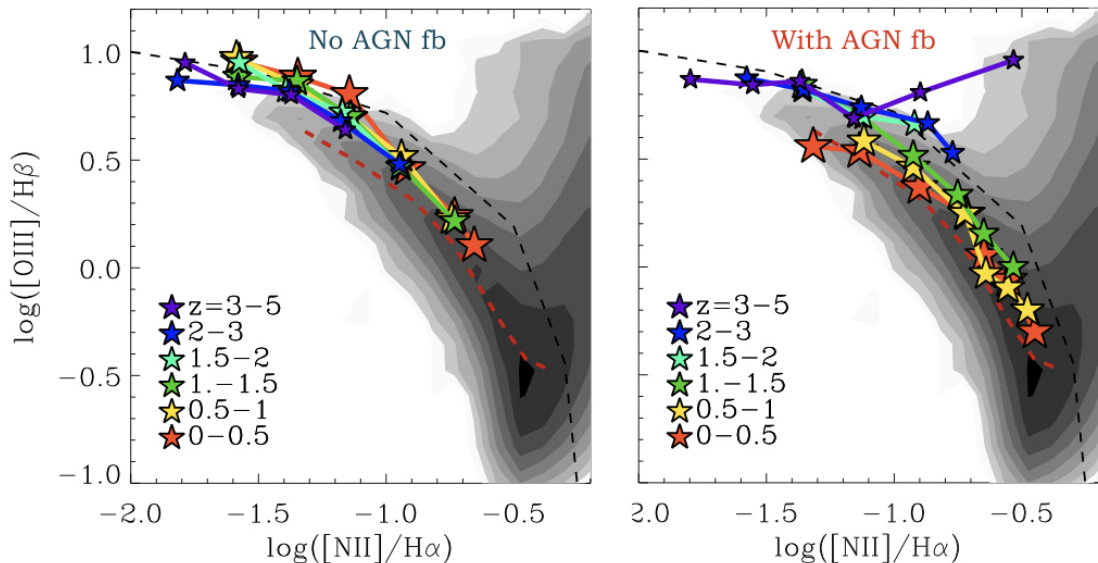
Figure 7. Average [OIII]/H β emission-line ratio in bins of [NII]/H α for the star-forming subset (i.e., with log (BHAR/SFR) < − 4) of the massive galaxies simulated with (right panel) and without AGN feedback (left panel) in different redshift ranges (connected stars of different colors). To guide the eye, SDSS data are shown in grey (adapted from